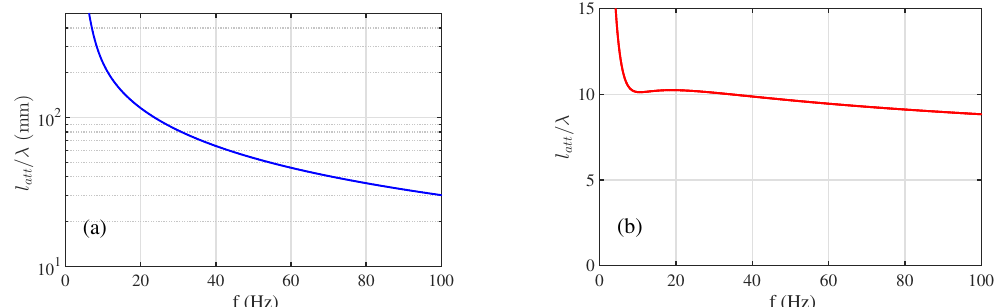
Figure 6. ( a ) Attenuation length l att = v g / ( δ WB + δ inex ) as a function of the frequency f of the wave. v g is the group velocity, δ WB is the the damping rate due to wall and bottom friction (Equation (56)), and δ inex is the damping rate according to the inextensible film model in presence of contamination (Equation (72)). ( b ) Ratio of the attenuation length with the wavelength l att / λ as a function of the frequency f . Capillary waves are typically damped on a length of about 10 wavelengths.